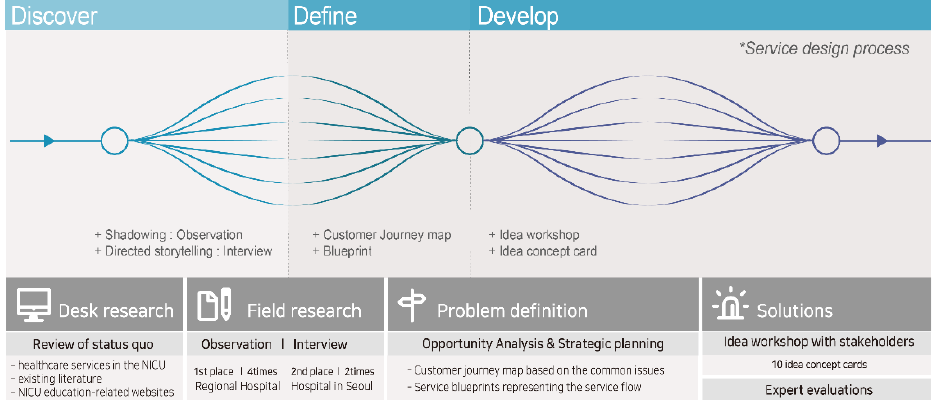
Figure 1. Research methods based on service design of this study.